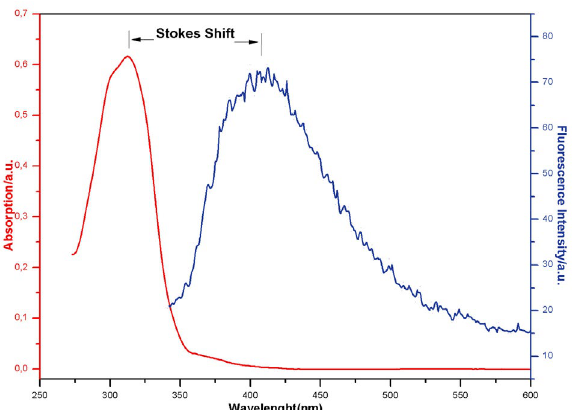
Figure 3. The absorption and emission spectra of the complex in DMSO at 10 –5 M.